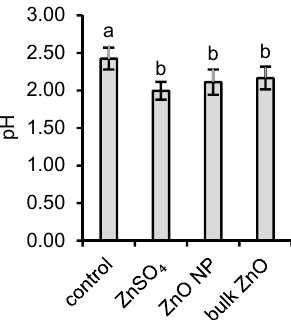
Figure 1. pH of the growth media after the experiment; a and b represent the statistically similar means between different groups at α = 0.05 (two-tail t -test).